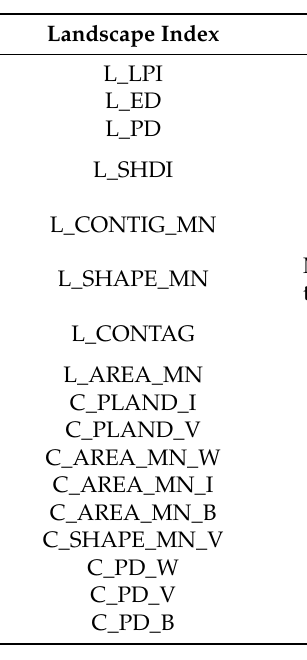
Table 3. Landscape metrics of